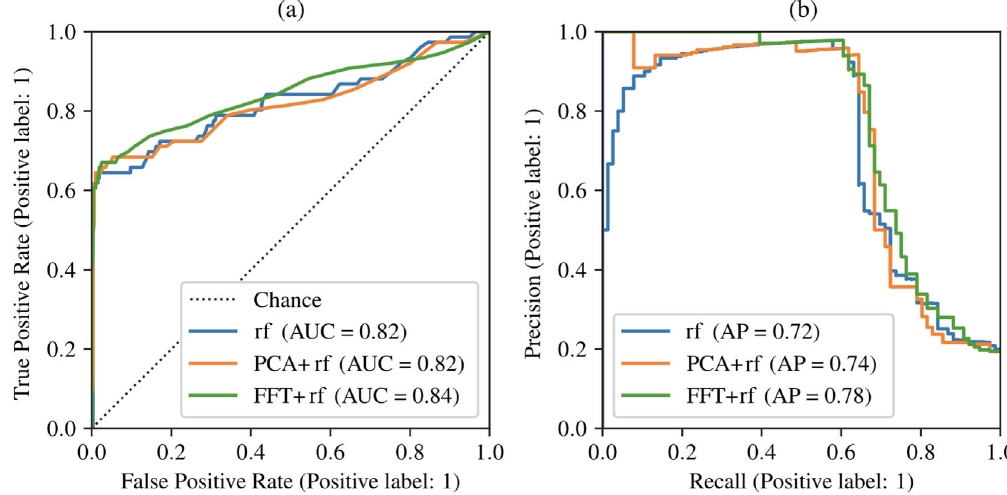
15).FIG. 5. The ROC curve (left) and precision-recall curve (right) of the rf classifier baseline, rf with PCA and rf with FFT models applied on the beam loss dataset (from [61], Fig.